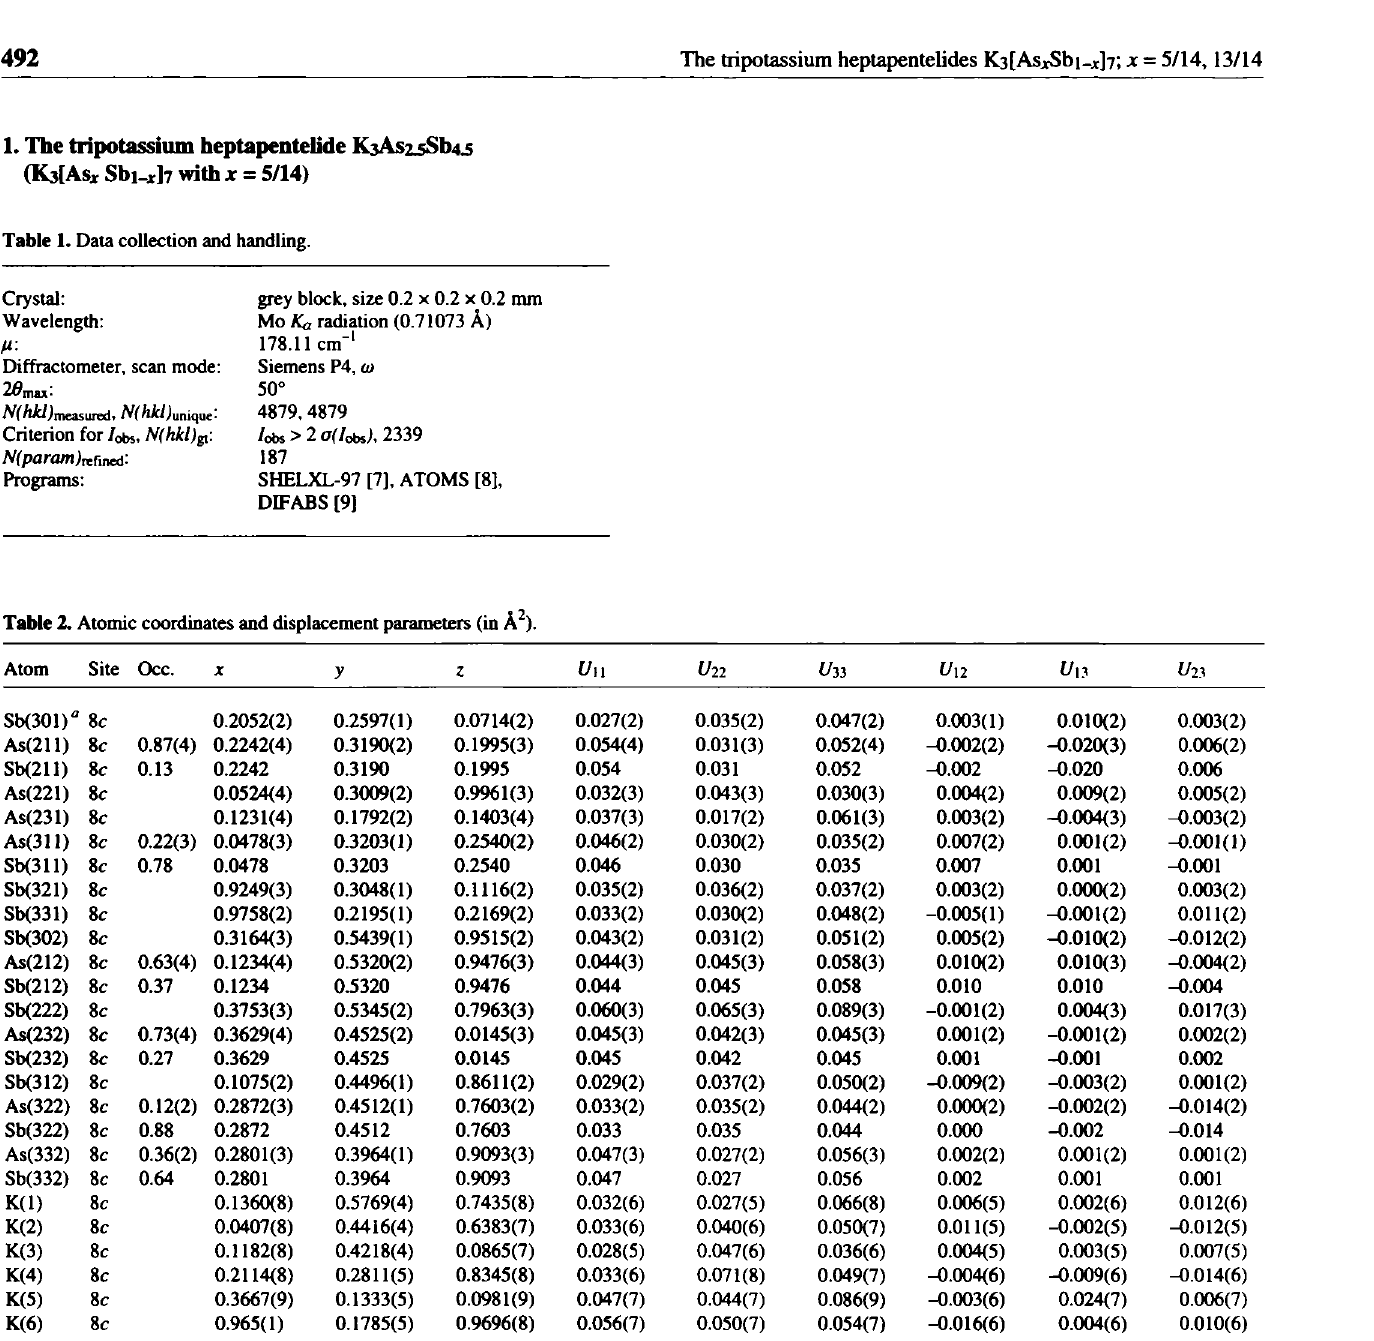
Table 1. Data collection and handling.